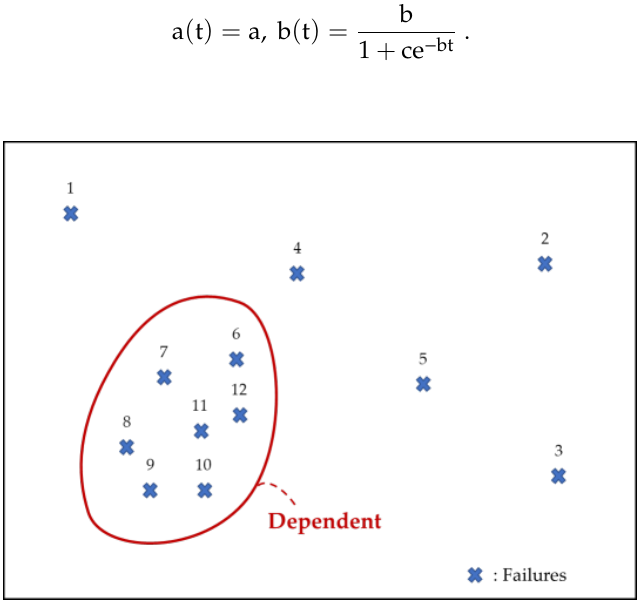
Figure 2. Structure of proposed model.